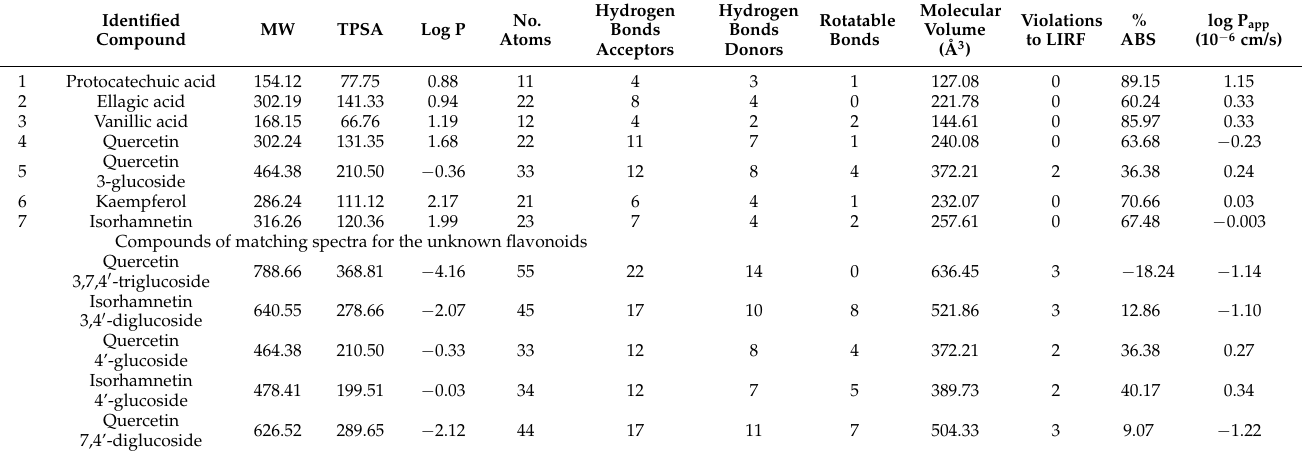
Table 3. In-silico study of the phenolic compounds in the onion